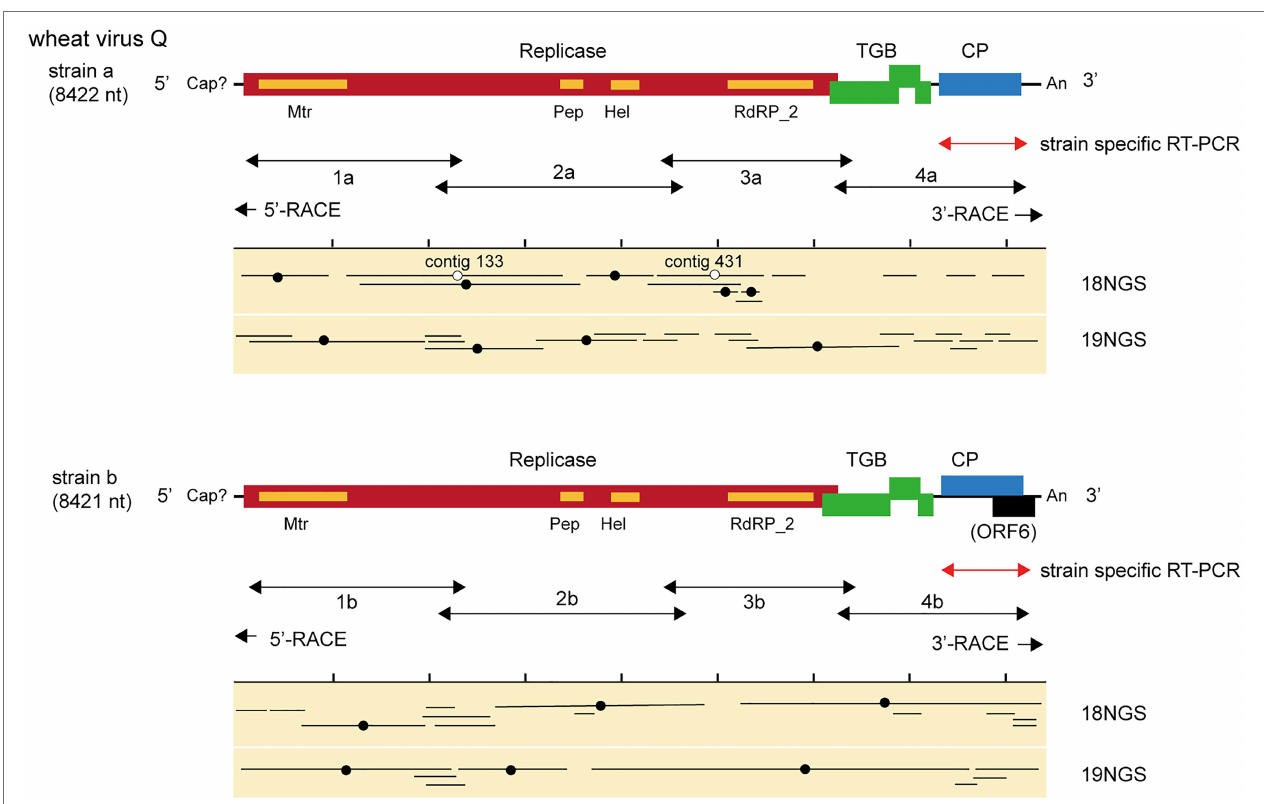
FIGURE 2 | Virus sequences of novel quinvirus (wheat virus Q, WVQ) strains identified from the RNA sequencing (RNA-seq) of wheat leaves. The black lines in the genomic RNA show ORFs. The conserved domains in the WVQ replicase are shown (Mtr, methyltransferase; Pep, Peptidase_C23 superfamily; HEL, RNA helicase; and RdRp_2, RNA-dependent RNA polymerase). The entire genomic sequence of the WVQ strains (a and b) was obtained from the overlapping RT-PCR products and the 5 ꞌ and 3 ꞌ RACE products (see the double-arrowed or arrowed lines below each schematic genome of the WVQ strains for RT-PCR target regions). A genomic region of WVQ, as indicated by the double-arrowed red lines, was used for strain-specific detection by RT-PCR in Figures 1, 6 . The primers used in the RT-PCR and RACE analyses are listed in Supplementary Table S1 . Virus-sequence contigs from two separate total RNA pools of wheat leaf samples (18NGS, pool-18L; 19NGS: pool-19L) are shown. The lines marked with a black filled-circle are the contigs listed in Supplementary Table S2 , and they were used for constructions of the WVQ genomic sequences. Some unlisted contigs in Supplementary Table S2 were also used for the construction of strain a sequence. The lines marked with an open circle were potentially derived from the variant(s) of WVQ strain a that have sequences slightly different from the reference strain a. The read depth coverage throughout the WVQ genomes (strains a and b) is presented in Supplementary Figure S2C